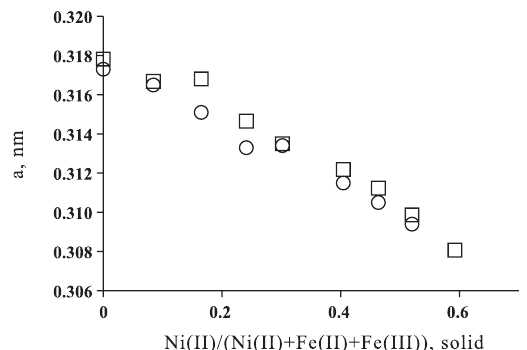
Figure 3. Reduction of the unit cell edge length a of the Ni(II)-GR2 samples as a function of Ni(II) content. Circles denote a -values determined by XRD measurements. Squares denote a -values determined by equation